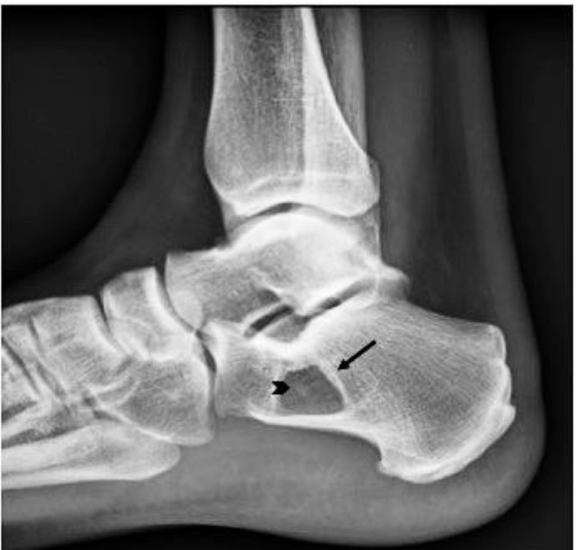
Figure 1. Plain radiography, lateral projection. Lytic calcaneus lesion (arrow). Small central sclerotic focus (arrowhead)-“Cockade sign”